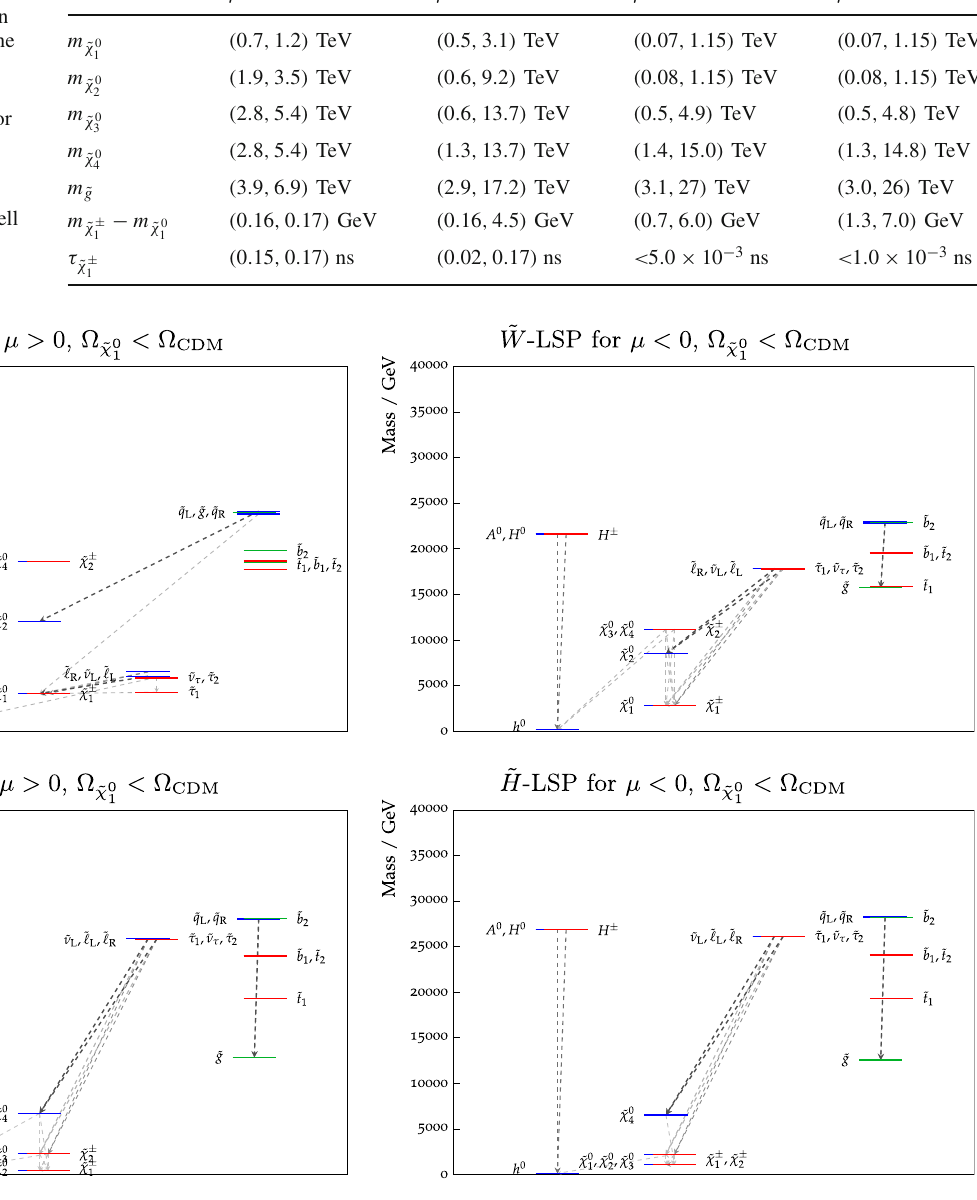
Fig. 17 The spectra of our best-fit points for μ > 0 ( left panel ) and μ < 0 ( right panel ), allowing the LSP to contribute only part of the cold dark matter density. Both the wino- ( upper ) and the Higgsino-like LSP ( lower ) best-fit points are shown. In each case, we also indicate all the decay modes with branching ratios (BRs) above 20%, with darker